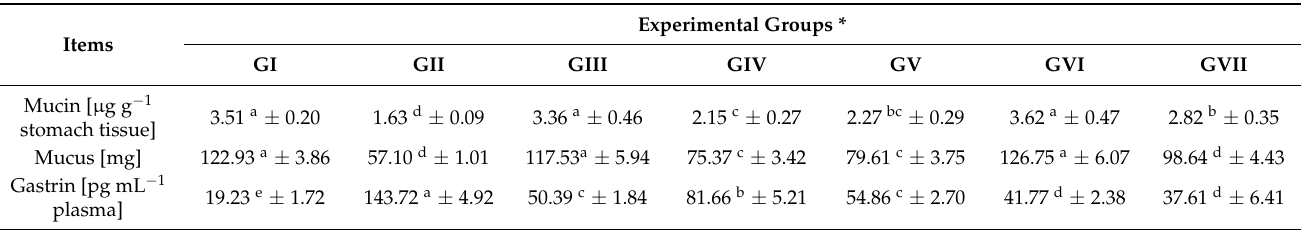
Table 3. Effect of SP, KF, KP, and SFP extracts on gastric mucus, gastric juice mucin, and plasma gastrin of indomethacin- induced gastric ulcer in rats (mean ± SE), n = 3.